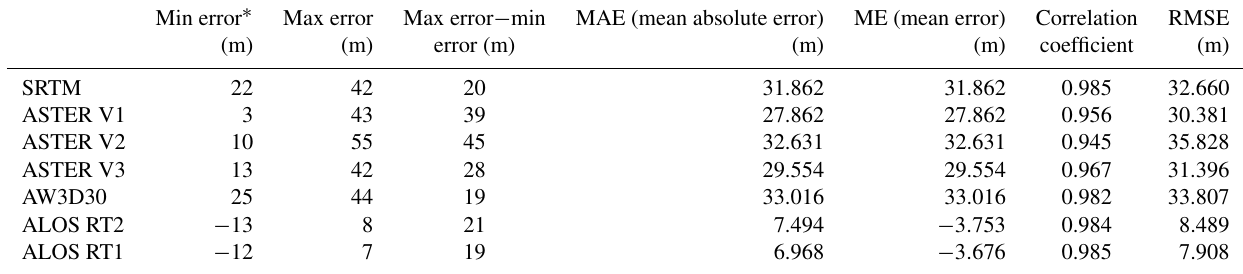
Table A3. Statistical analysis of seven DEMs in the mountainous western